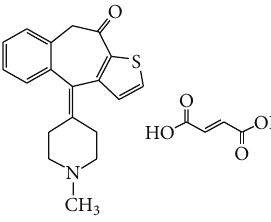
Figure 1: Structure of